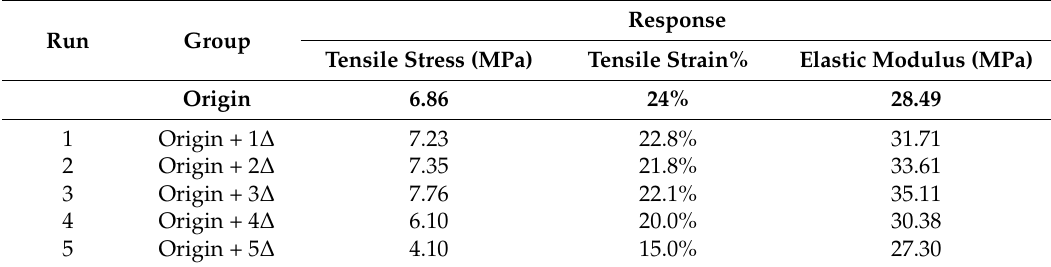
Table 3. Responses of tensile strength, tensile strain and elastic modulus.